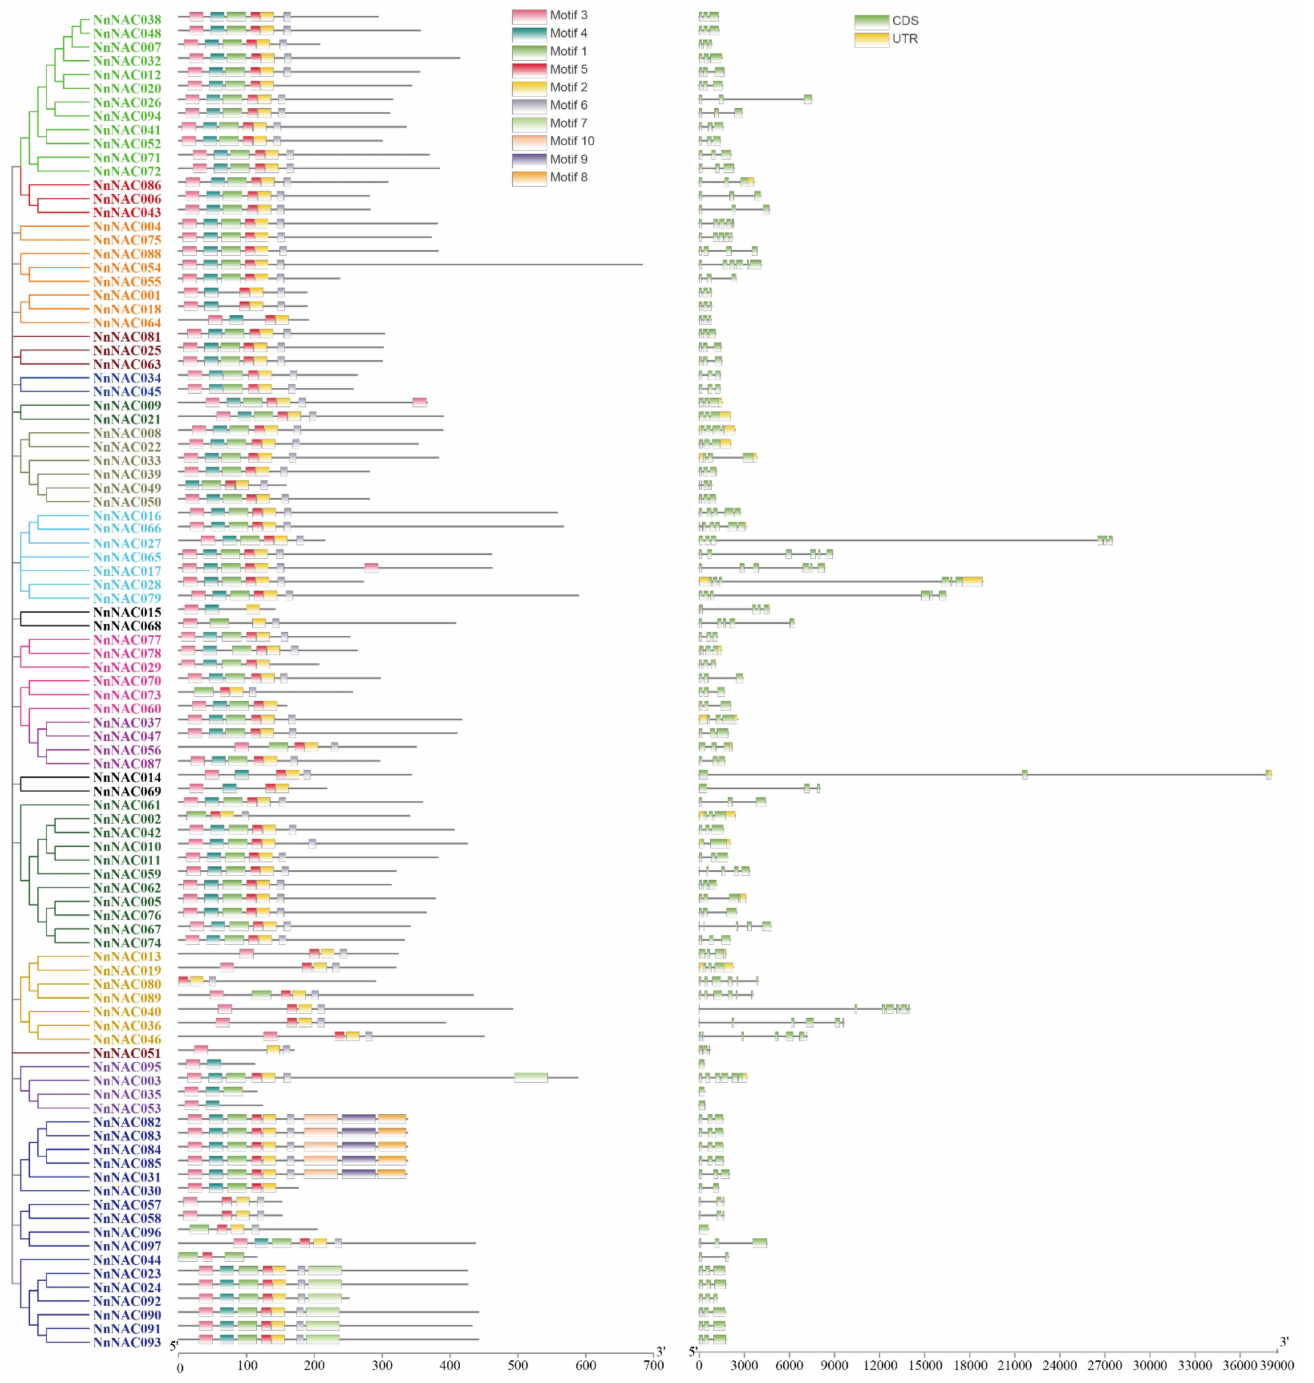
Figure 3. The structures of NAC genes and NAC proteins. The left represents the phylogenetic relationship of NAC genes. The middle represents the conserved motifs in NAC proteins, in which different colors represent different motifs. The right represents the intron–exon structures of NAC genes. The exons, introns, and untranslated regions (UTRs), are indicated by the green boxes, black lines, and yellow boxes,